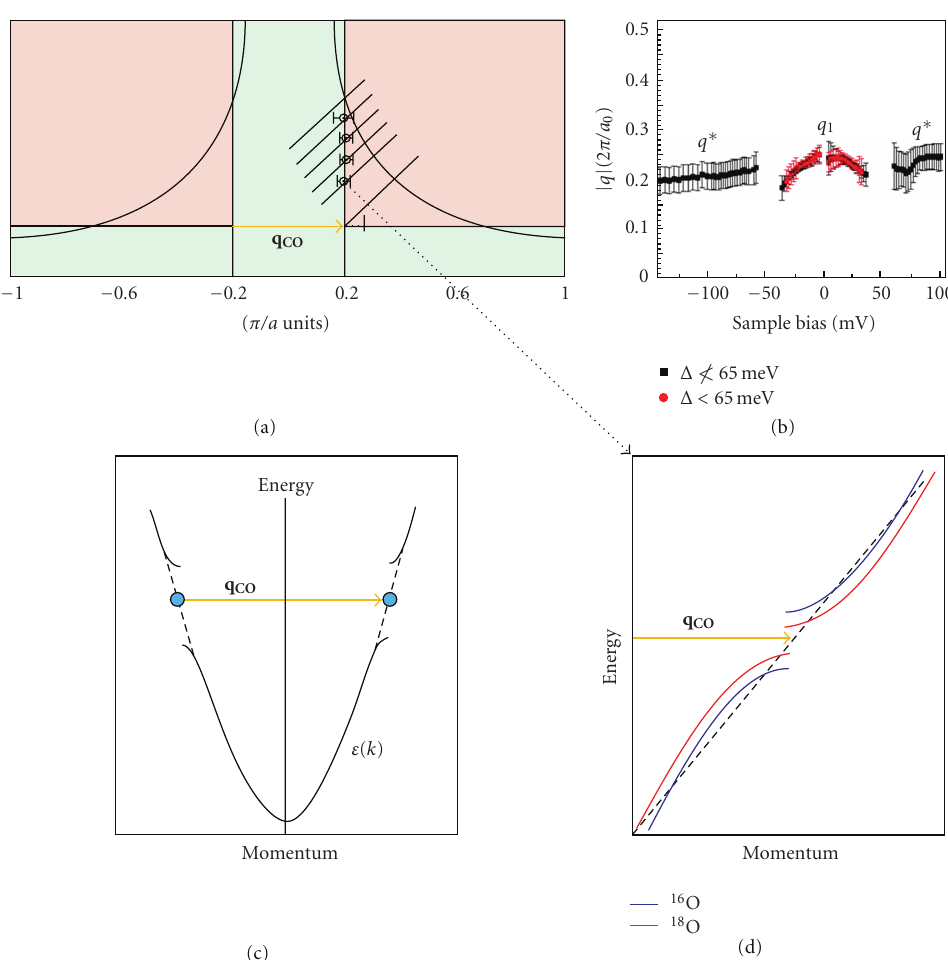
Figure 9: (a) Fermi surface of the upper half of the first BZ. Diagonal lines indicate cuts used in Figure 8 while circles indicate the location in momentum space of the sign change crossover point for each of those cuts. These lie on a line indicated by the wavevector, q CO and illustrated by the colored regions. (b) STM data independently determining this wavevector taken from [34]. (c) Cartoon illustrating how the charge ordering wavevector, q CO , can open a gap at a binding energy where the electronic states are nestable. (d) Additional cartoon illustrating how the splitting, if slightly di ff erent in magnitude between the isotopes, can explain the observed sign change in the bands and its evolution as the dispersions intersect with q CO